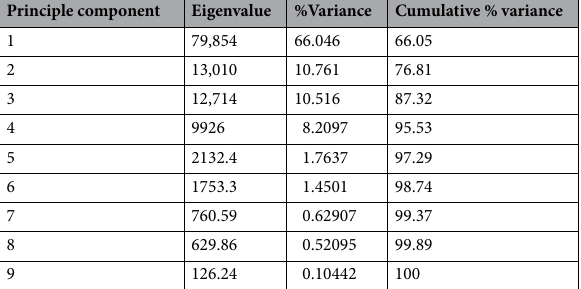
Table 3. Principal component and their respective Eigenvalue and per cent